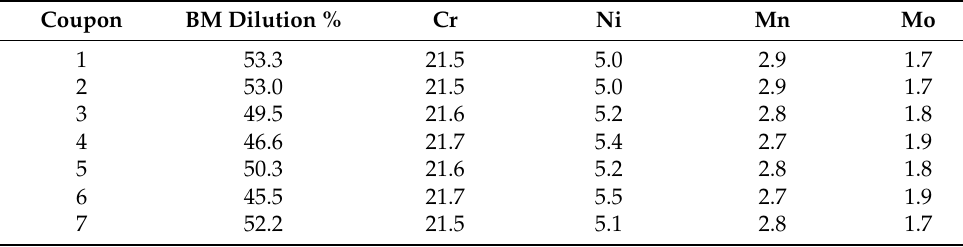
Table 4. Composition after dilution at node c.